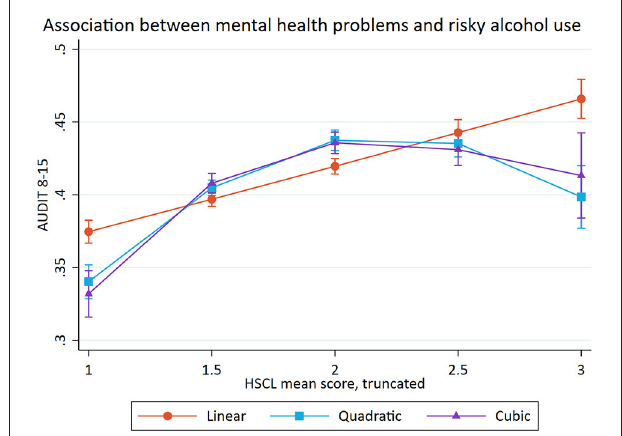
FIGURE 3 | Association between mental health problems and risky alcohol use (after the removal of 2.5% in each end of HSCL-25 scale). Predicted probabilities of alcohol-related problems (The Alcohol Use Disorders Identification test; AUDIT) across mean scores on Hopkins Symptom Checklist (HSCL). Error bars represent 95% confidence